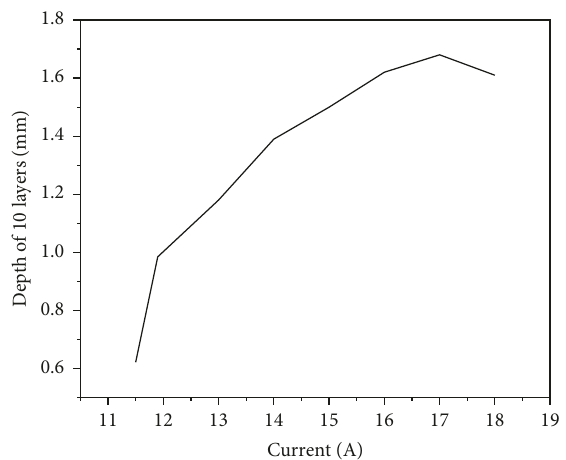
Figure 2: The relationship between laser power and engraving